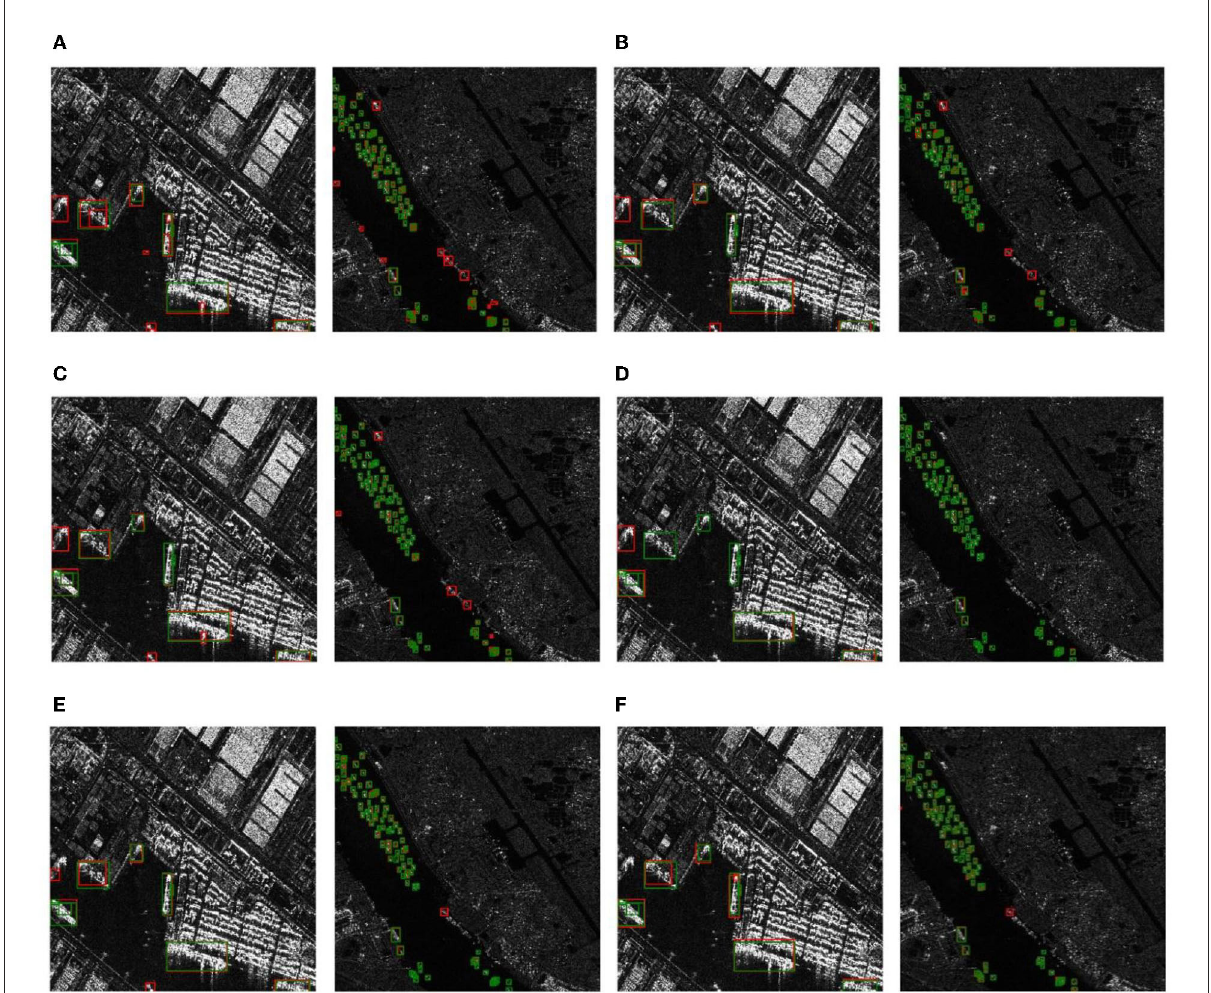
FIGURE6 Ship detection results of the target detection methods based on different models in complex scenarios. The SAR images on the left are scenes including the coast, and SAR images on the right are scenes including the port. (A) Fast R-CNN. (B) Mask-RCNN. (C) Cascade Mask R-CNN. (D) RetinaNet. (E) FCOS. (F) Proposed